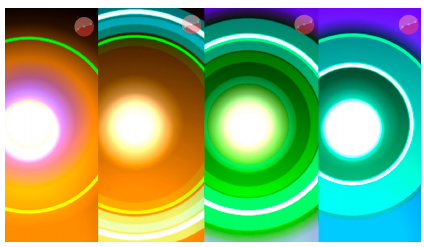
Figure 2. BrightHearts visualizations.